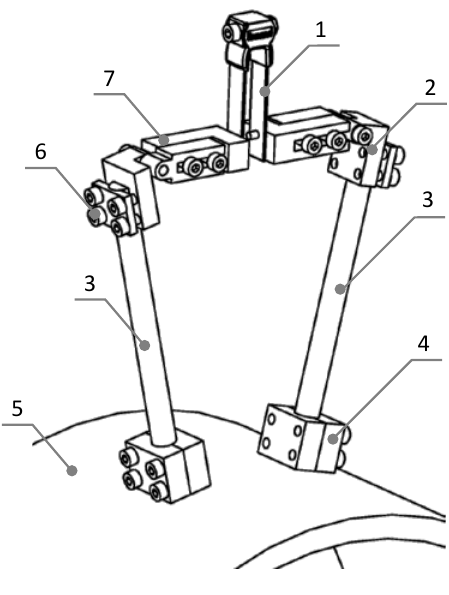
Figure 7. Location schematic of two extensomers on the same weld seam of a T-joint.